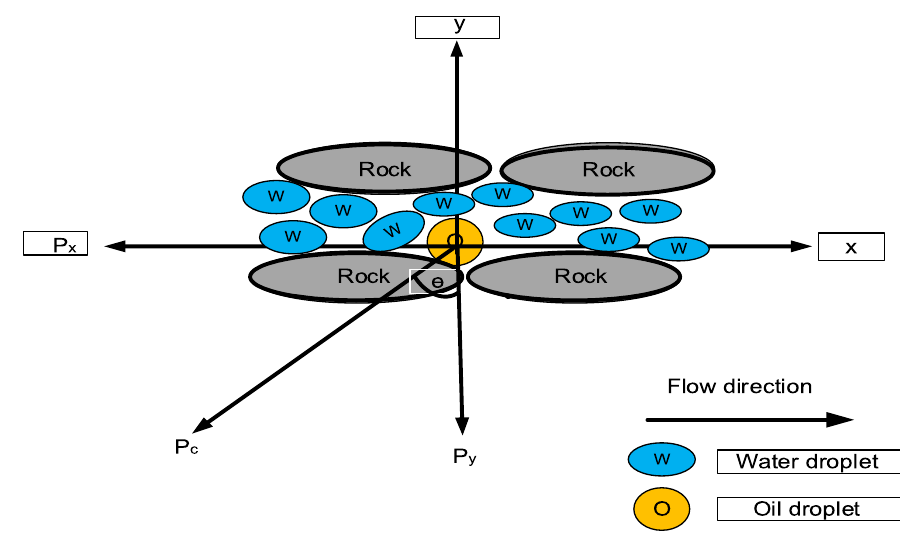
Fig. 3 Forces acting on an oil droplet when it is located on the top of a rock surface during water